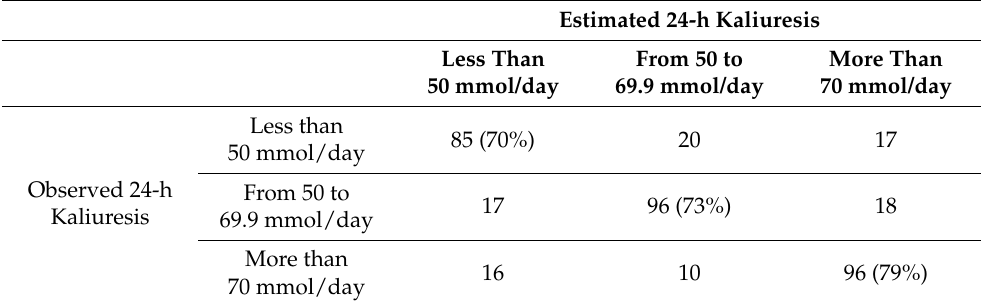
Table 3. Table of agreement between the predicted and observed 24-h urinary potassium excretion used to estimate dietary potassium intake of the 375 patients analyzed in the UniverSel study. Estimated 24-h Kaliuresis Less Than From 50